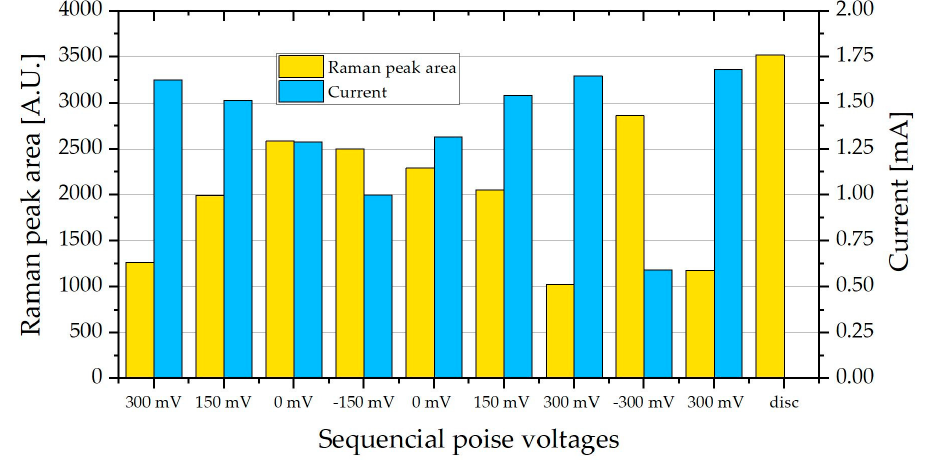
Figure 7. The Raman peak area at 745 cm − 1 of PCA biofilm in a microbial fuel cell (MFC) stack, average of two measurements along with the current produced at the different poised level. The current is inversely related to the peak area.